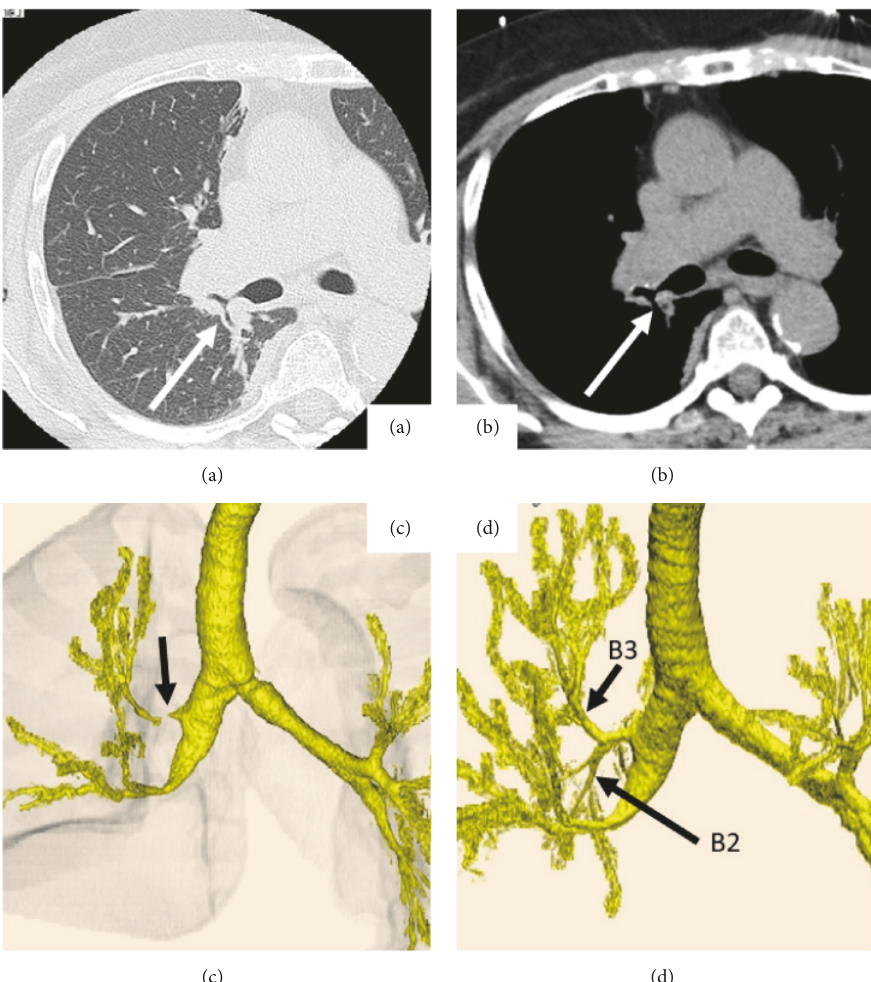
Figure 3: Follow-up chestcomputed tomography (CT) on postoperative day (POD) 3 with the (a) lung window, (b) mediastinal window, and (c) three-dimensional image revealing improvement of the hilar peribronchovascular soft tissue edema and right upper bronchial stenosis (arrows). (d) 3D-CTonPOD 14 showing thecounterclockwiserotation of rightupperlung lobeand improvementof the rightupper bronchial